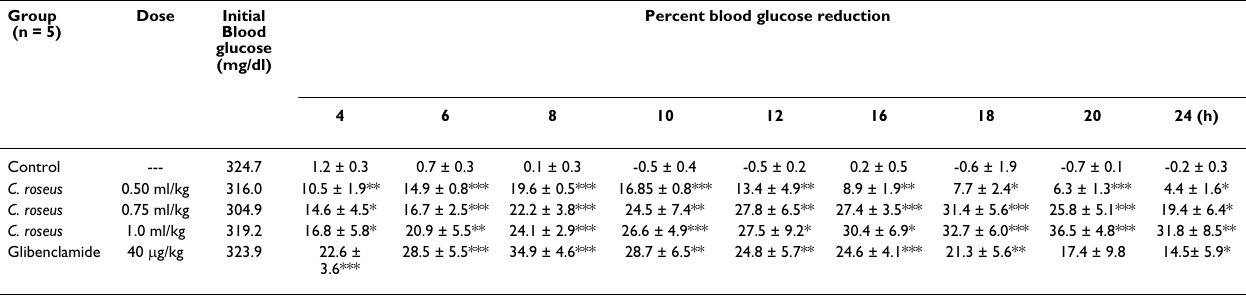
Table 2: Percentage blood glucose reduction produced by C. roseus after oral administration in alloxan-induced diabetic rabbits. Group (n =